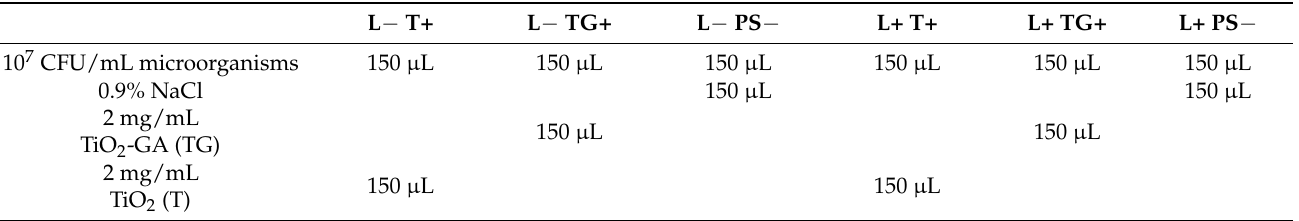
Table 1. Amounts of ingredients added to the wells of a microtiter plate during an experiment involving 3 strains of microorganisms.